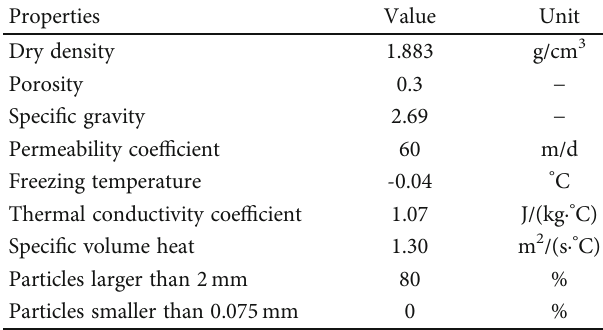
Table 1: Physical and thermal properties of gravel